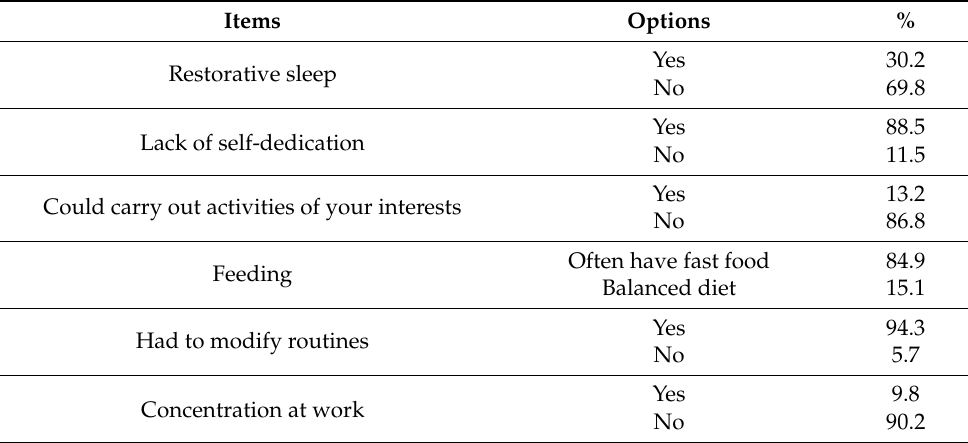
Table 2. Impact of the hospital stage on the parents’ lives.